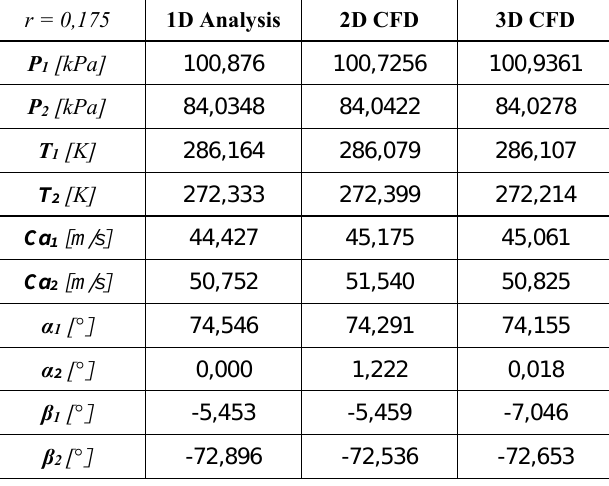
Table 3. Results on mean radius (r = 0,175 m).